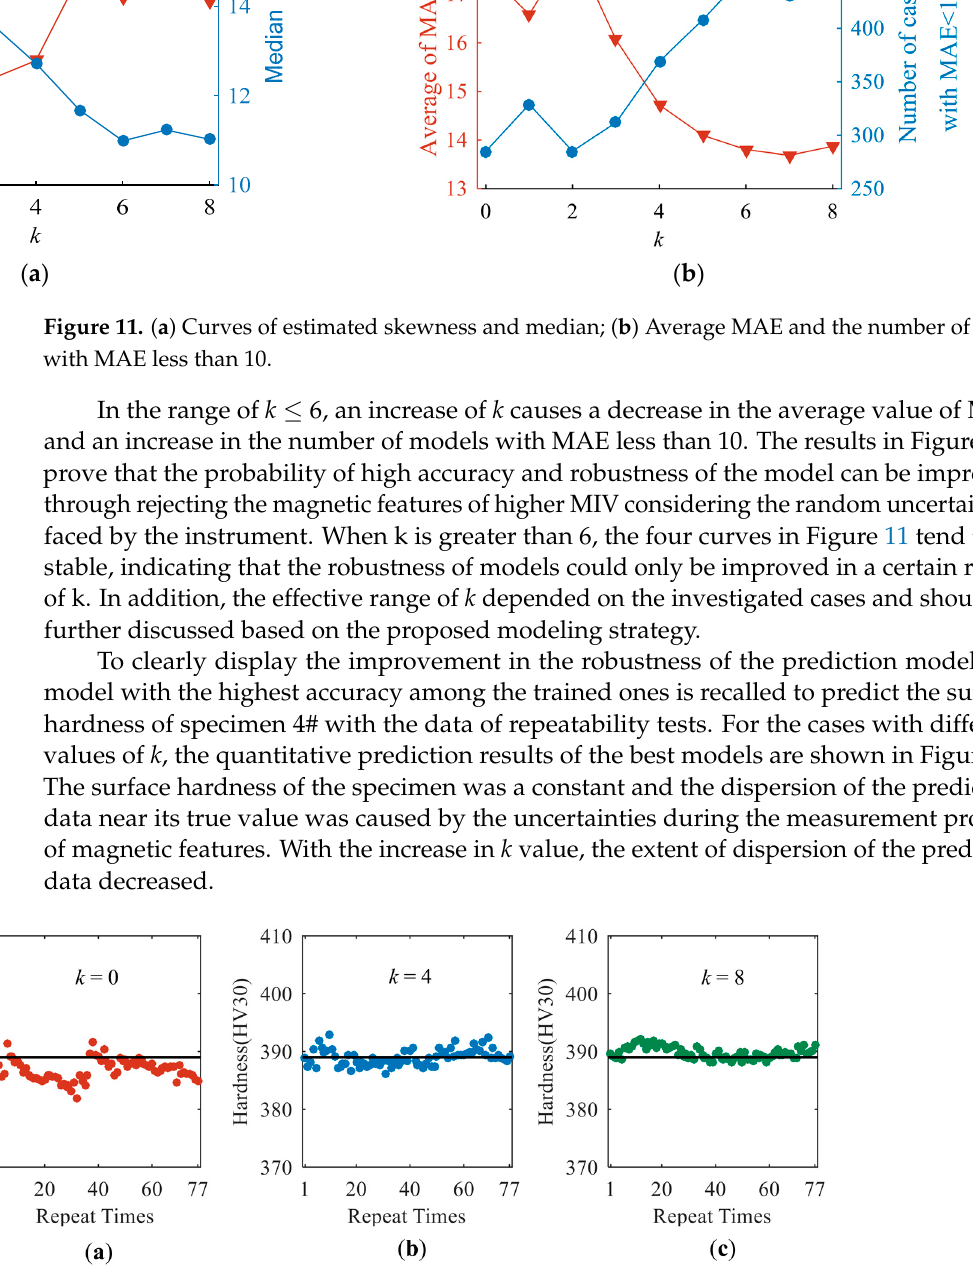
Figure 12. ( a – c ) show the quantitative prediction results of surface hardness with the models of k = 0, k = 4 and k = 8,